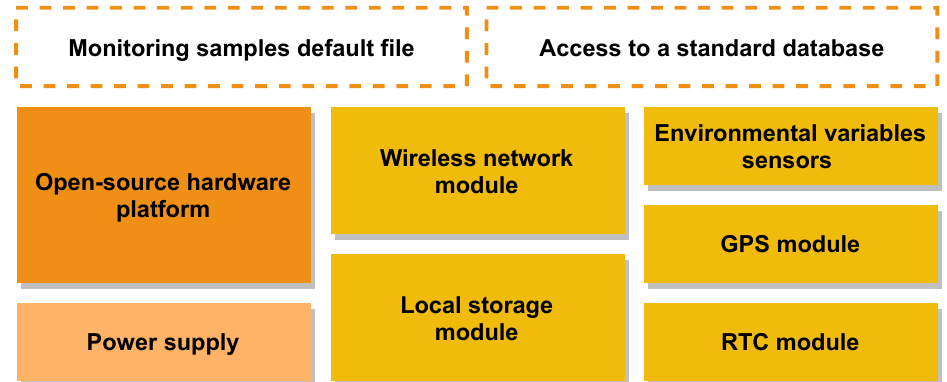
Figure 2. The fundamental requirements of the iBikeSafe sensing